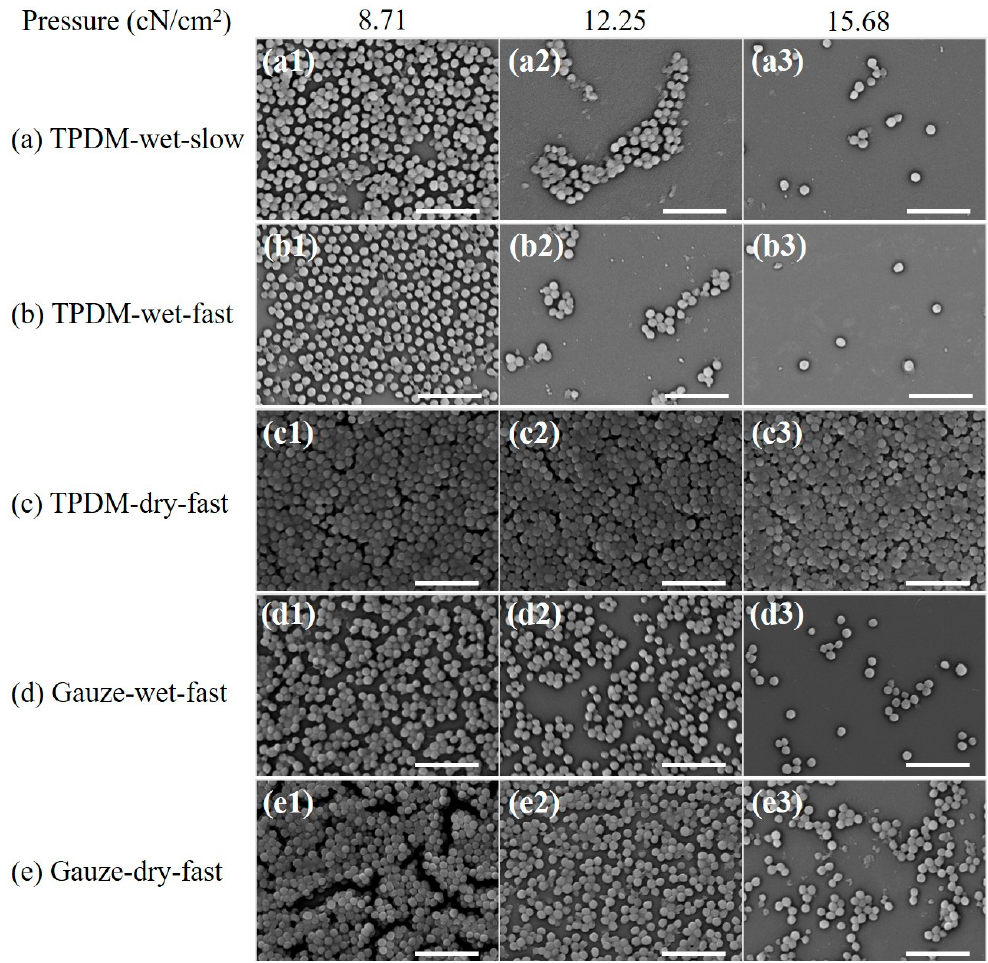
Figure 15. SEM images after in vitro biofilm removal tests (scale bar: 5 μ m): ( a )TPDM-wet-slow, ( b ) TPDM-wet-fast, ( c ) TPDM-dry-fast, ( d ) Gauze-wet-fast, ( e ) Gauze-dry-fast.